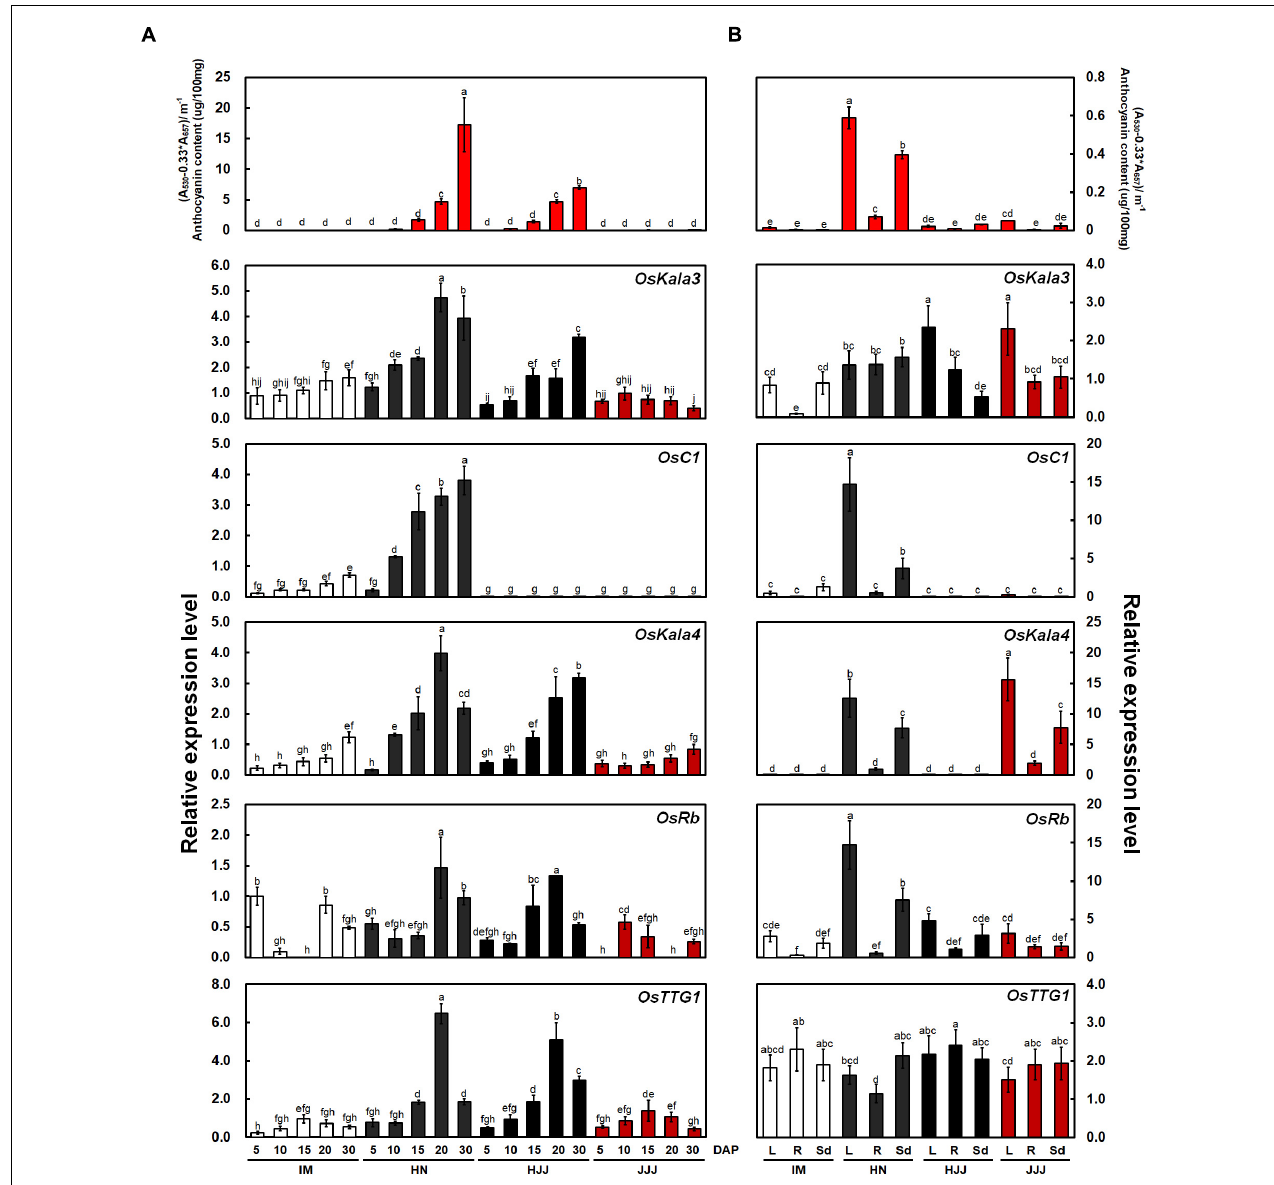
FIGURE 1 | Anthocyanin contents and expression analysis of OsKala3 and other putative anthocyanin regulatory genes from developing rice seeds and young seedling stage. (A) Mean anthocyanin accumulation in developing rice seeds from non-pigmented (IM), black (HN and HJJ), and red (JJJ) rice varieties during seed maturation (top). Relative transcript levels for regulators of anthocyanin biosynthesis (bottom). DAP, days after pollination. (B) Anthocyanin contents (top) and transcript level (bottom) of anthocyanin regulator genes in various tissues of the young seedlings stage (14 days after sowing). L, leaves; R, roots; Sd, seedlings. Results represent mean values ± SD from three independent biological replicates. Different letters above the bars indicate significantly different values ( p < 0.05) calculated using two-way ANOVA followed by Duncan’s multiple range